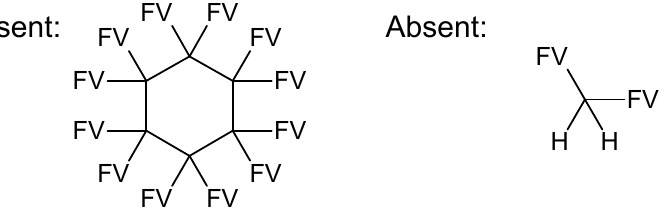
Figure A11. Substructures for GC–MS Challenge 12. FV = free valence.